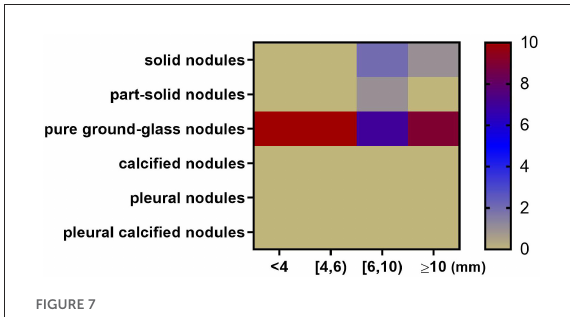
FIGURE7 Heatmap depicting nodule types and diameters most likely to be missed by 10 algorithms. The x axis represents nodule size range. The y axis represents nodule type. For example, when the nodule diameter is between 6 and 10mm, 7 AUTs are most likely to miss pure ground-glass nodules; 2 AUTs are most likely to miss part-solid nodules; 1 AUT is most likely to miss solid